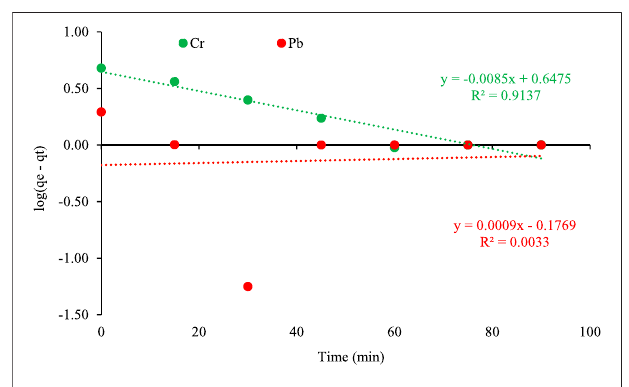
FIGURE 8 | Pseudo First Order kinetic plot of metal adsorption on orange peel/selenium